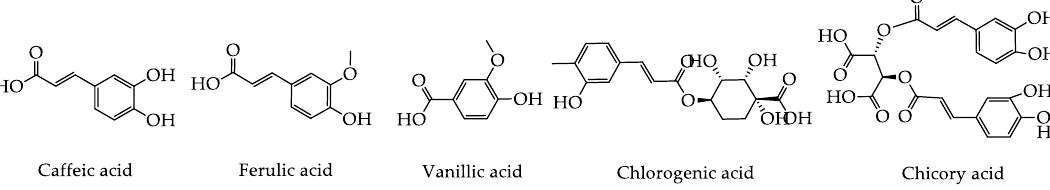
Figure 4. The basic structure of hypouricemic effects from phenolic acid bioactive components in plant-based functional foods.